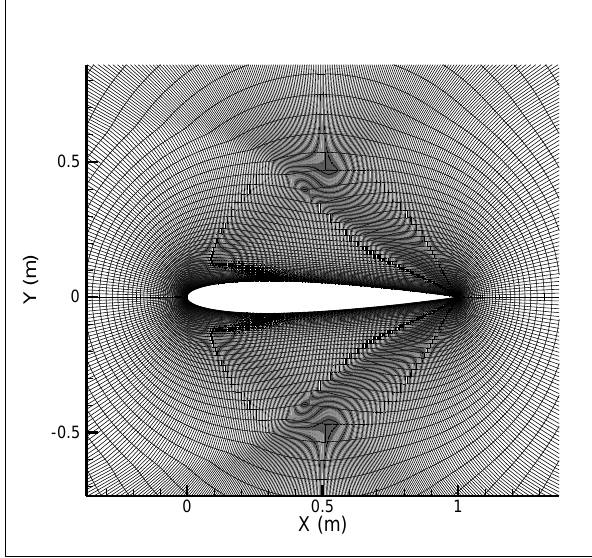
Figure 6. Structured mesh (hyperbolic O-grid) used for solving the transonic flow equations. The size of the mesh was 109 × 601. Fluids 2020 , 5 , x